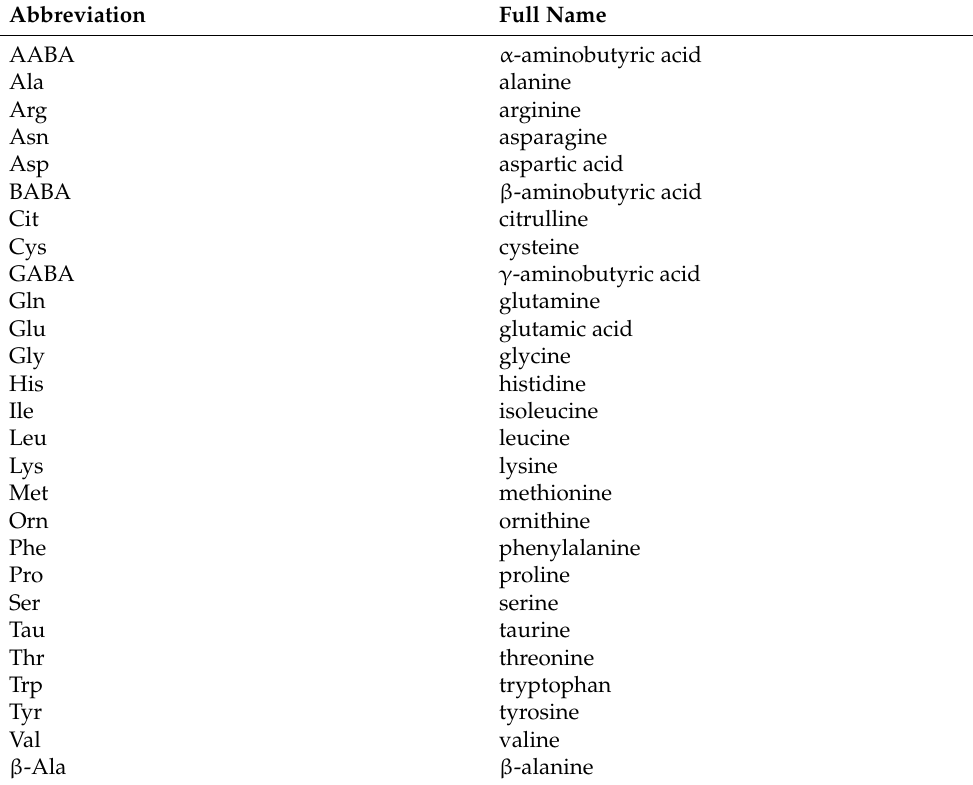
Table 5. Amino acids evaluated during HPLC